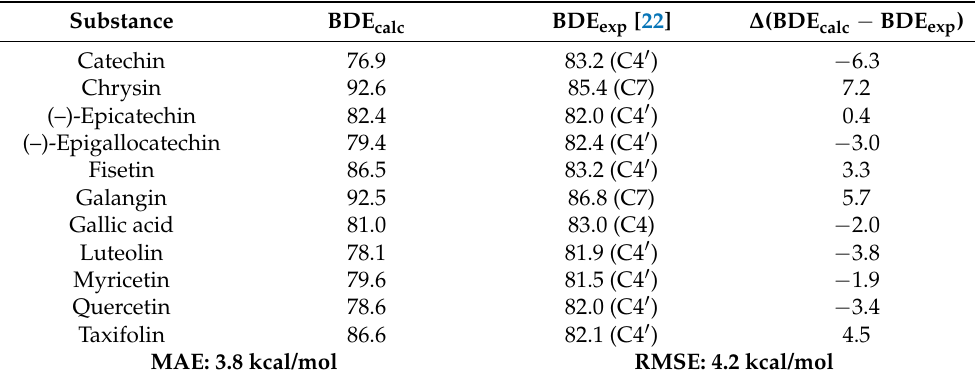
Table 2. Validation set for BDE values (in kcal/mol) at